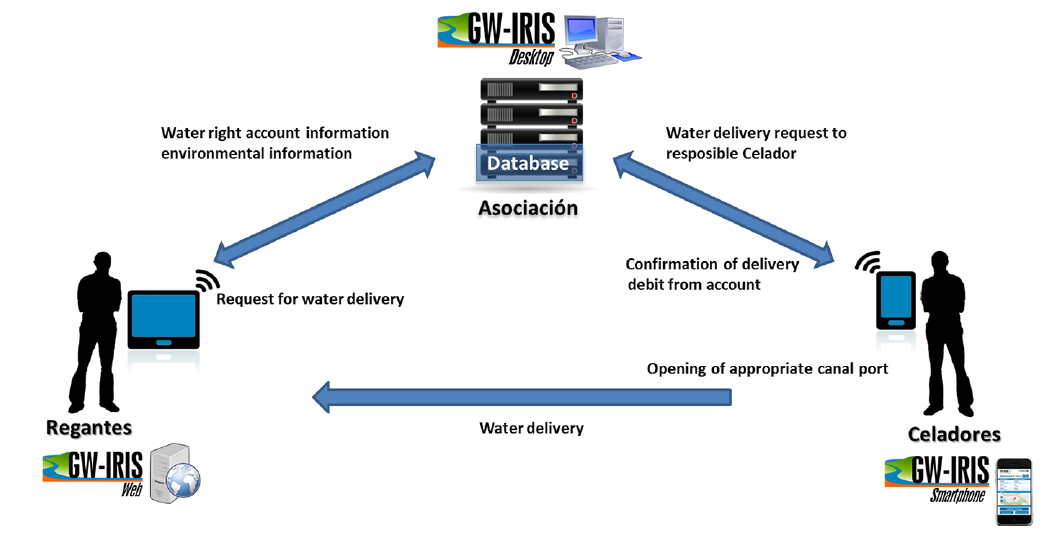
Figure 3. GW-IRIS communication scheme.